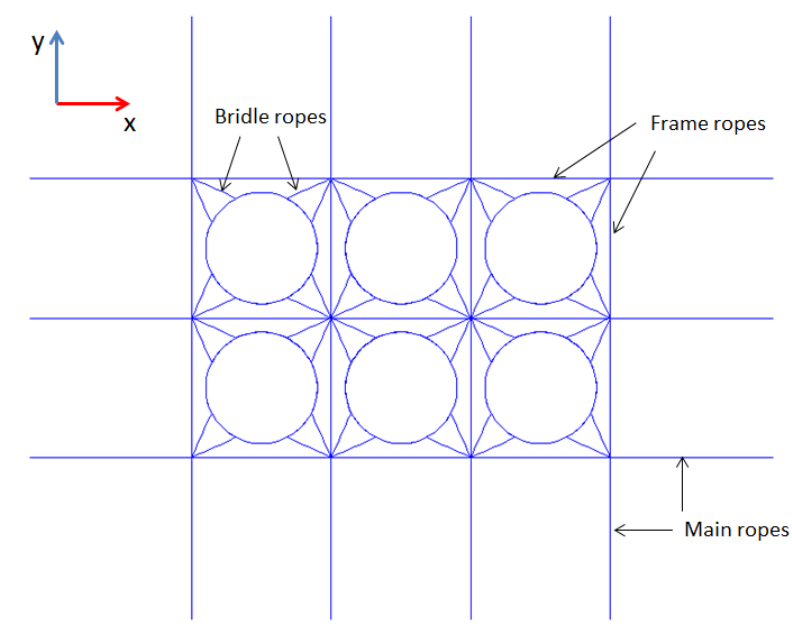
Figure 1. The schematic diagram of the mooring system.